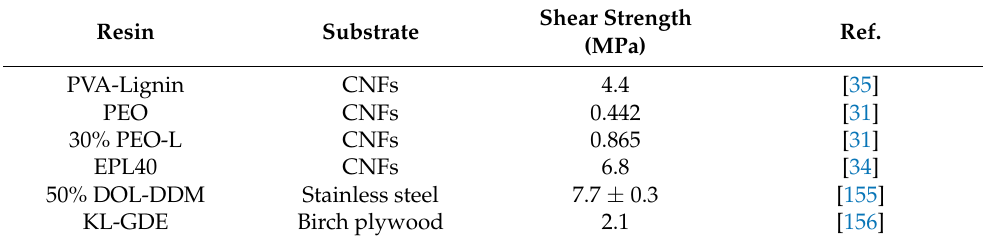
Figure 12. An illustration of the shear lap joint test of bio-based resins with CNF films ( a ) and cross-sectional SEM images of the specimens for PVA-lignin ( b ) [35] and PEO-lignin resins ( c ) [15]. Table 3. Adhesion strength performance of lignin-based